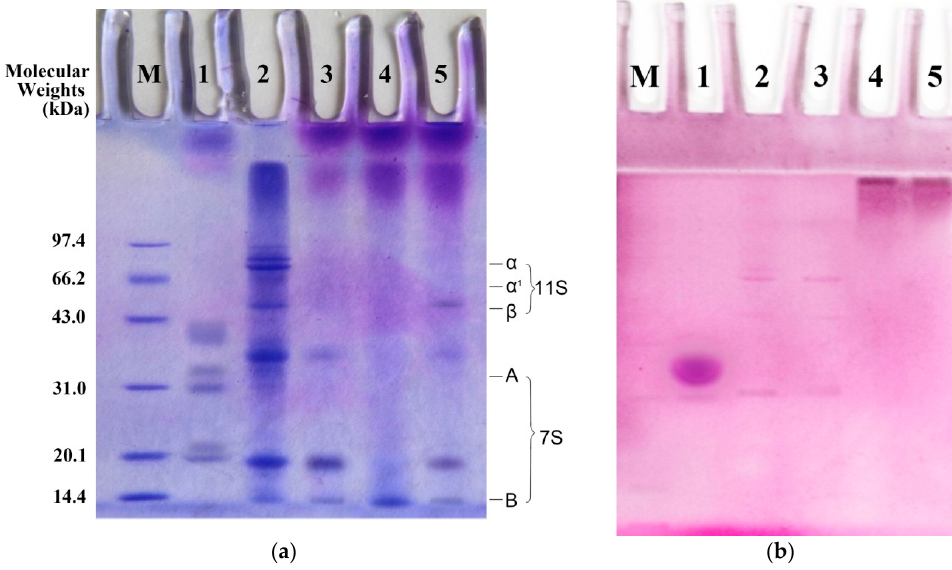
Figure 1. Electrophoretic profiles of analysis samples stained for protein ( a ) or saccharides ( b ). ( a ) protein staining; ( b ) glycocalyx stain. M represents standard protein marker; 1 represents horseradish peroxidase; 2 represents BSPI; 3 represents ECBSPI; 4 represents WHTGBSPI; 5 represents EGBSPI.